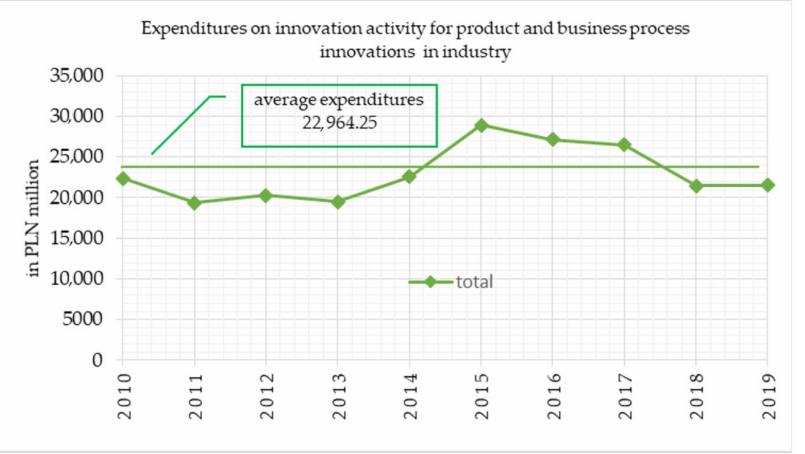
Figure 11. The amount of spending on innovation activity for product and business process innova- tions in the industry total in Poland. Source: adapted with permission from Refs.